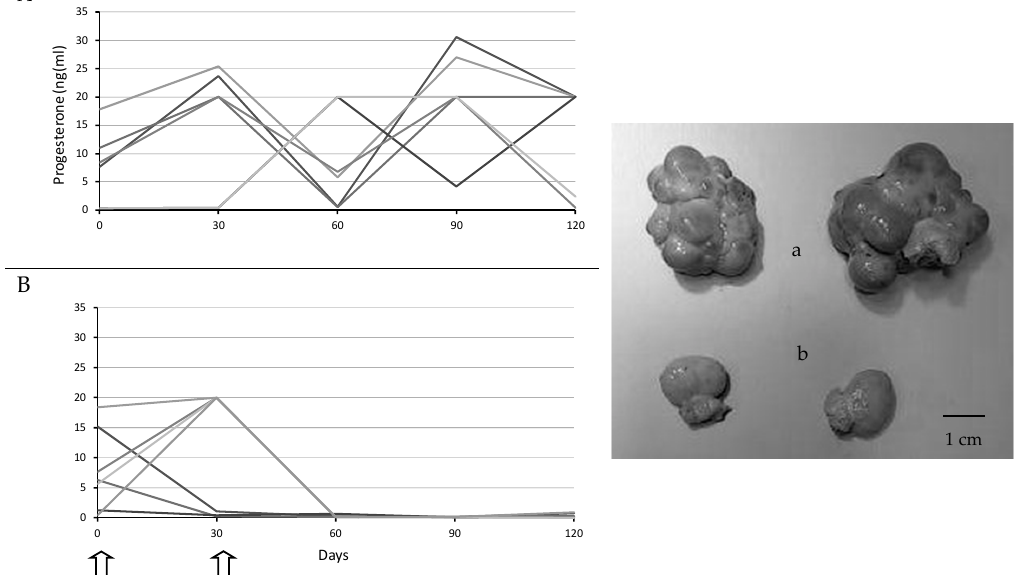
Figure 1. Individual plasma progesterone concentrations over time of study (left hand) and picture of the ovaries at 120 days (right hand) in sows used as controls ( A and a ) or treated with two doses of Vacsincel ® for inducing ovarian inactivity ( B and b ); arrows indicate timing of treatment).